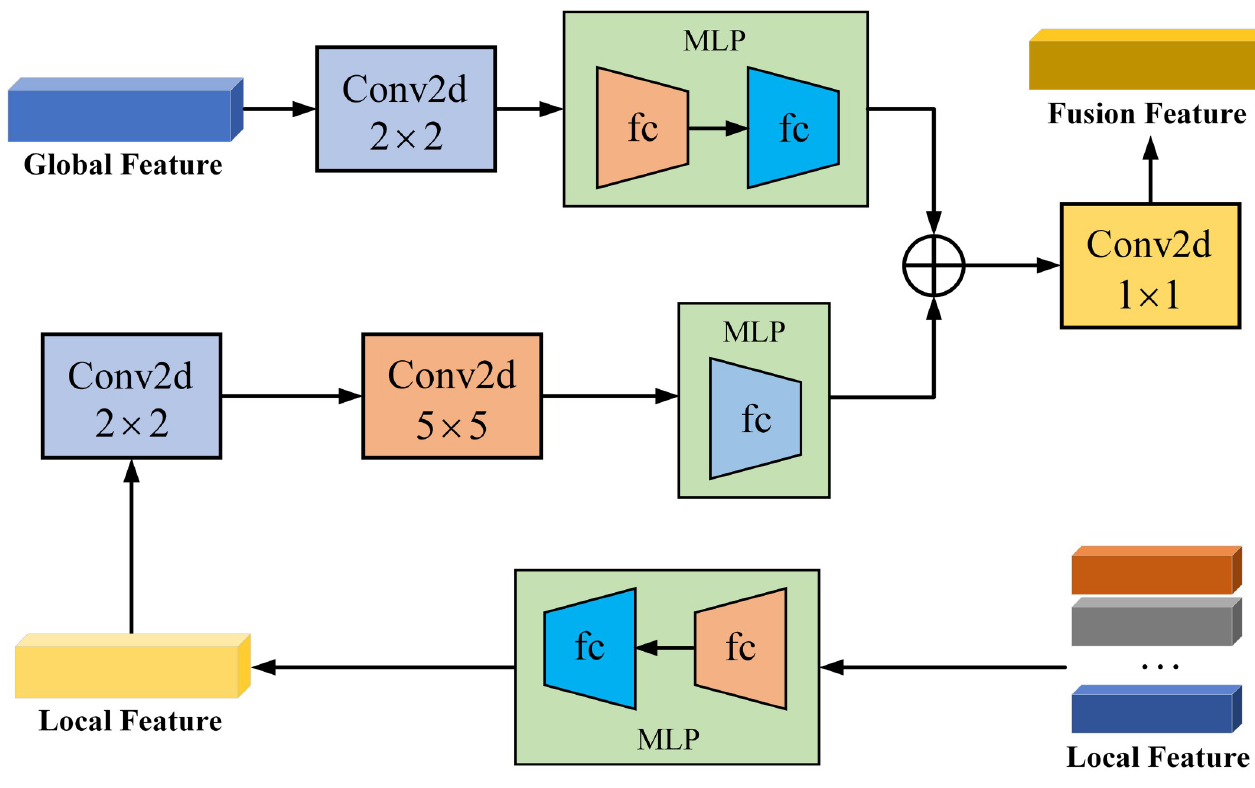
Fig 3. Global and local image feature